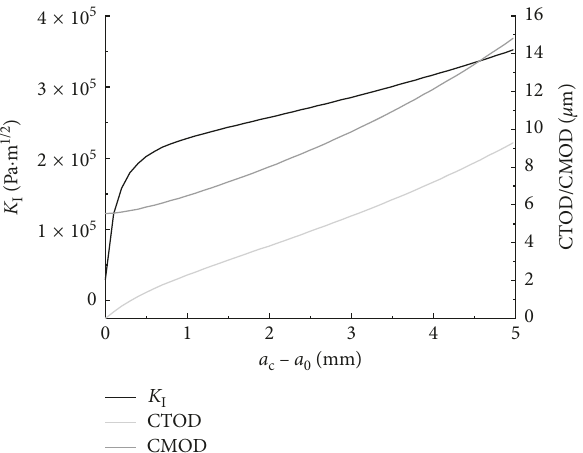
Figure 5: Typical K I , CTOD, and CMOD versus effective crack extension plot.